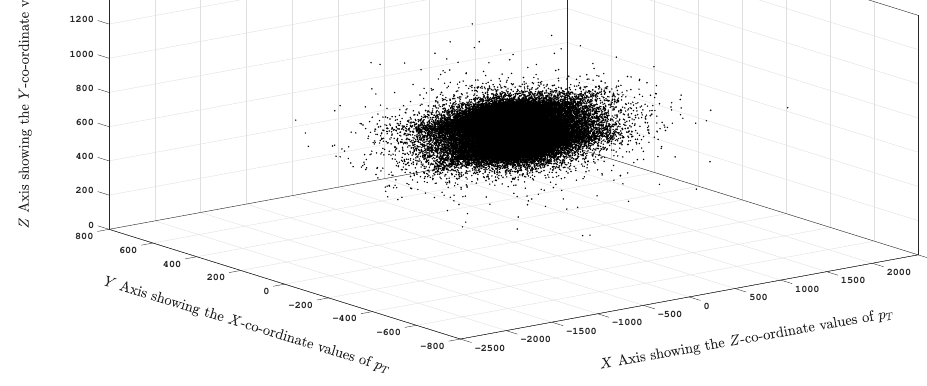
Figure 4. Data space— [ z , x , y ] ss .